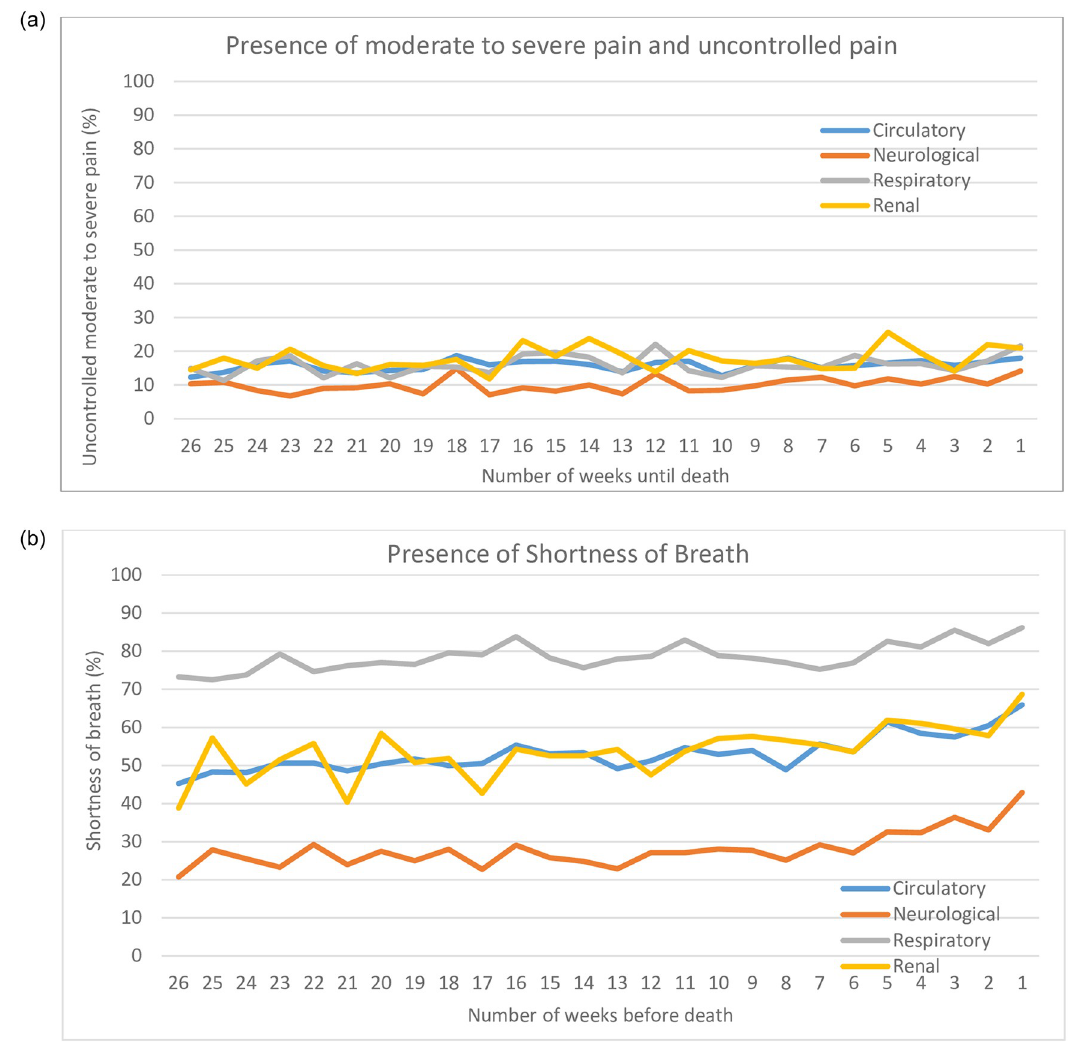
Fig 1. Physical symptom prevalence in the last 6 months of